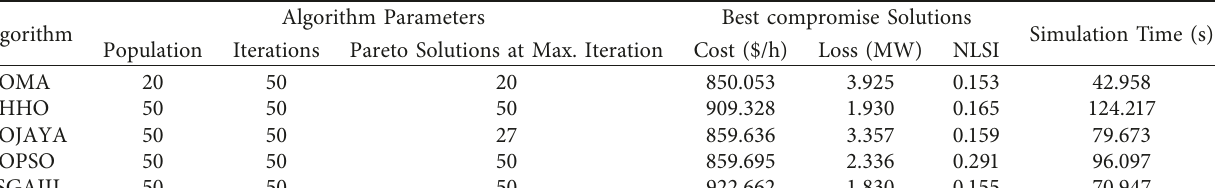
Table 11: Validation of SC-2 Case 6 MOMA results against other algorithms.